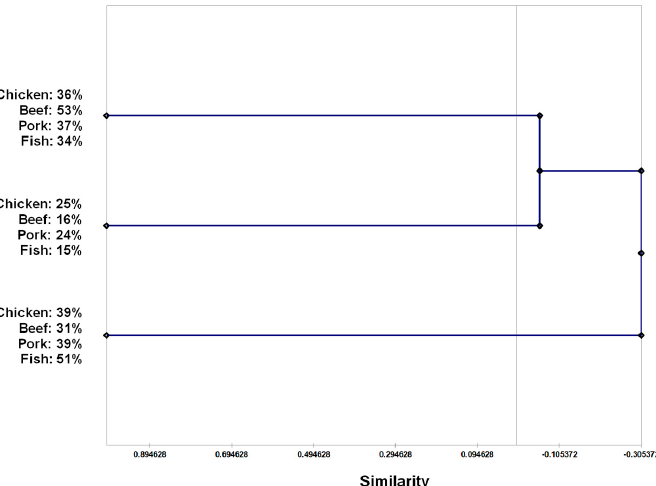
Figure 1. Similarity phenogram from hierarchical clustering analysis by UPGMA (unweighted pair group method with arithmetic mean) with bootstrap of 1000 × based on antimicrobial resistance or antimicrobial susceptibility of mesophilic facultatively anaerobic Gram-negative rods isolated from meat and fish samples.